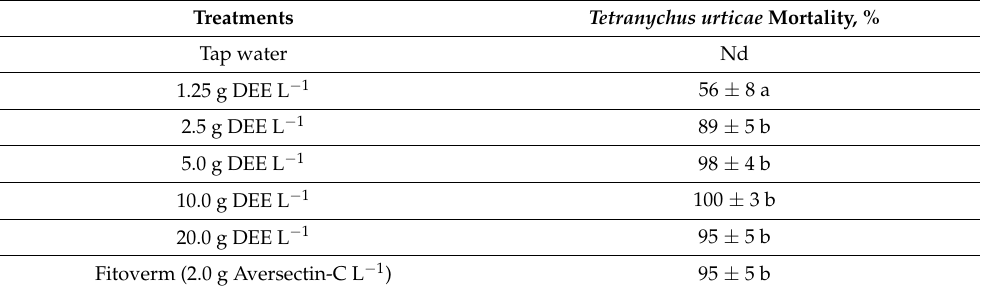
Table 5. Acaricidal activity of the dried ethanol extract (DEE) of Streptomyces sp. P-56 against two-spotted spider mite ( Tetranychus urticae ) on the infected common bean